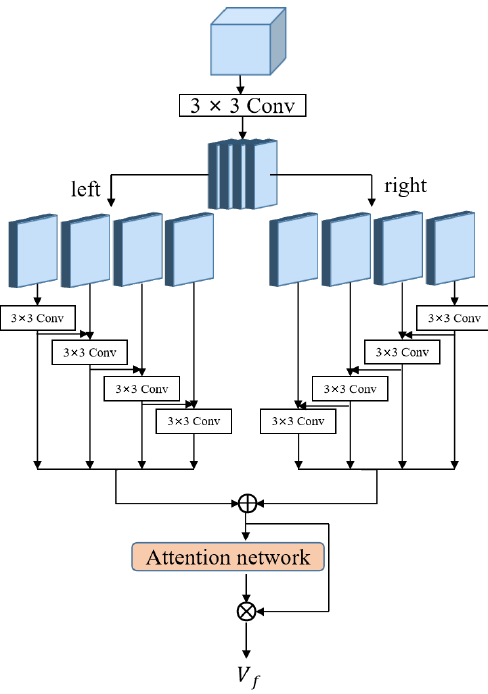
Figure 3. The structure of Multi-Scale Attention module.